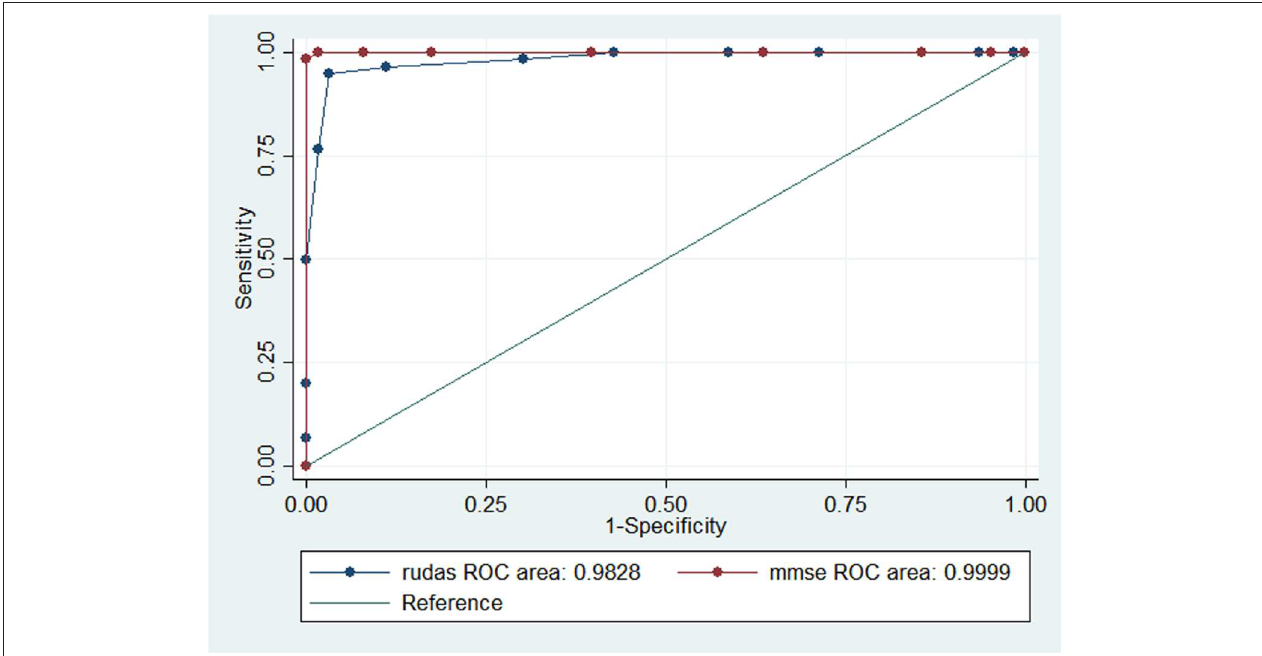
FIGURE 2 | Receiver-operating characteristic (ROC) curve for the Peruvian version of the Rowland Universal Dementia Assessment Scale (RUDAS-PE) and the Mini Mental State Examination (MMSE) in 124 patients for discrimination between mild cognitive impairment (MCI) and control groups. Centros de Salud de Ventanilla, Callao, Lima. 2018-2019.